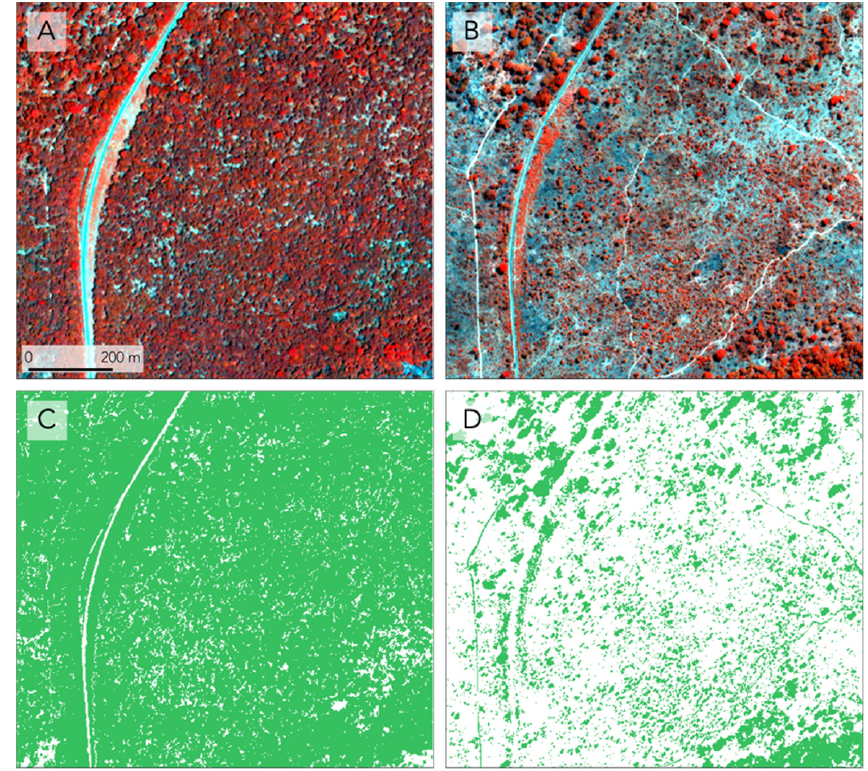
Figure 9. Detailed view of tree cover changes before and after charcoal production for two grid cells (1 × 1 km) in Katarino forest reserve. ( A ) Pre-disturbance false-color composition (1,2,4) of WorldView-2 image (2013); ( B ) post-disturbance false-color composition (1,2,4) of WorldView-2 image (2016); ( C ) pre-disturbance tree cover; ( D ) post-disturbance tree cover.